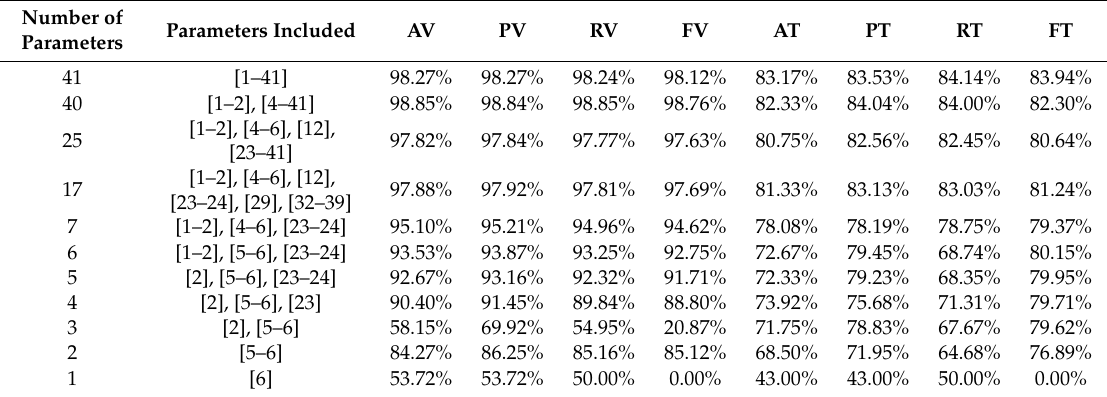
Table 9. Intrusion detection performance by using di ff erent